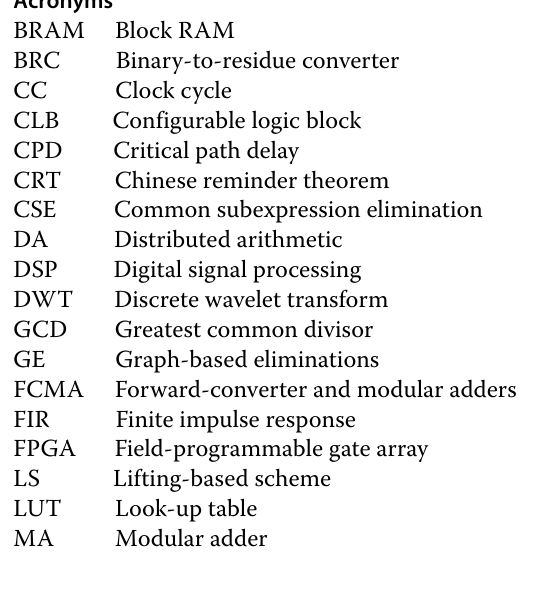
key feature of this approach is that the user can change the scaling factors, y and z , either to achieve high PSNR values or lowering the PSNR value in order to design multi-level DWT with low latency.